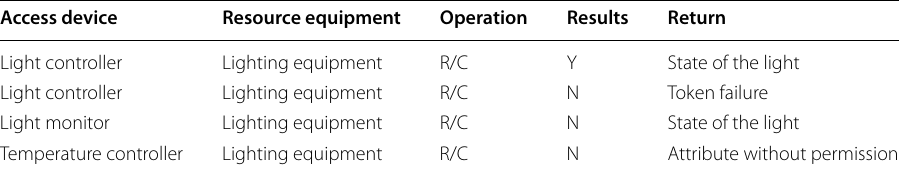
Table 2 The simulation